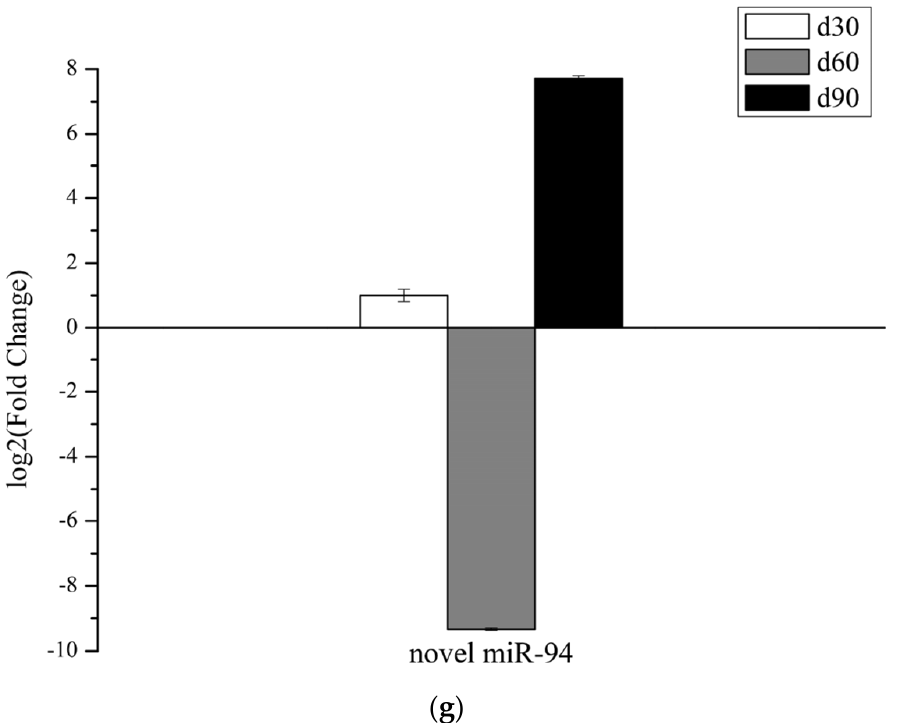
Figure 6. Results of qPCR validation. MicroRNA expression was assessed by qPCR in growth centers of velvet antlers in three growth stages. The relative expression levels were calculated by the 2 − ∆∆ Ct method. ( a ) bta − miR − 1298; ( b ) bta − miR − 486; ( c ) novel miR − 166; ( d ) ppy − miR − 1; ( e ) mmu − miR − 200b − 3p; ( f ) novel miR − 6; ( g ) novel miR − 94.